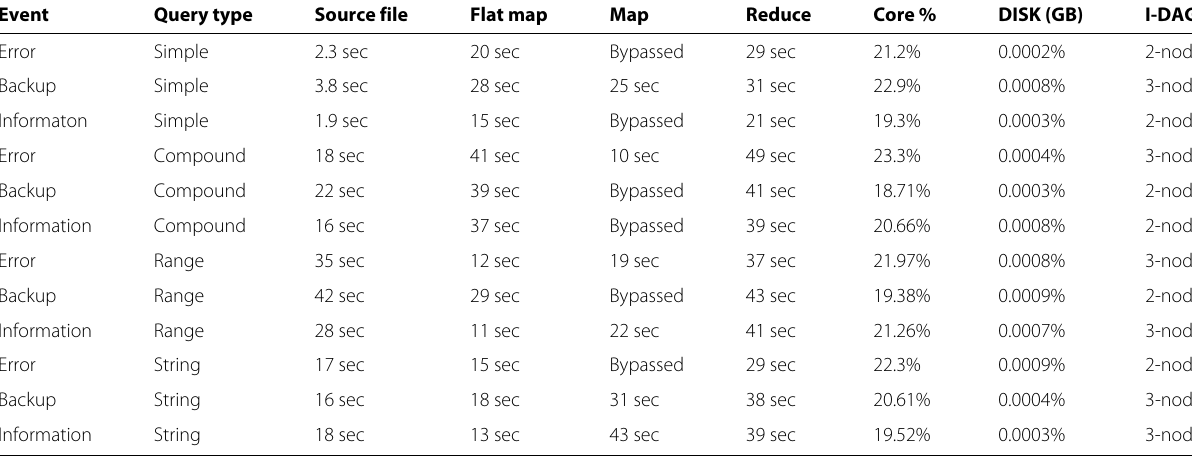
Table 7 Heterogeneous stream I-DAG workflow Stage 0 →